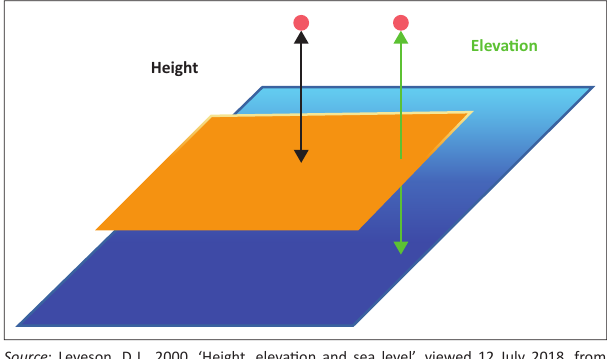
FIGURE 3: Height, elevation and mean sea